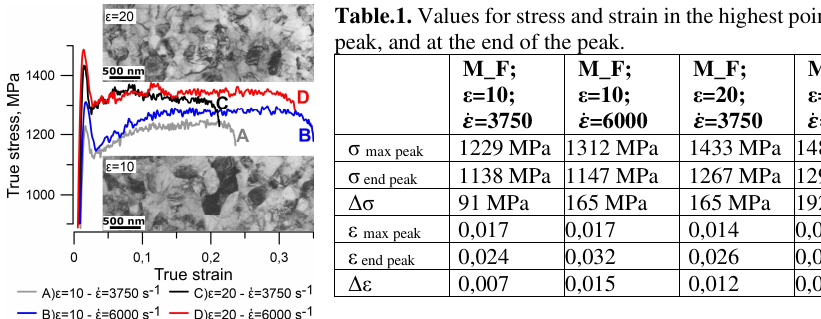
Fig. 4. The initial fragments of stress-strain curves. M_F 20 specimens SHPB test with various strain rates. Additionally TEM microstructures from MaxStrain with accumulated strain ε =10 and ε =20.